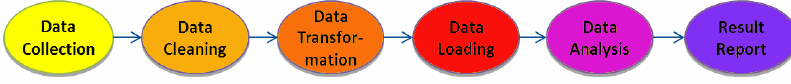
Figure 1. Normal process of data mining.